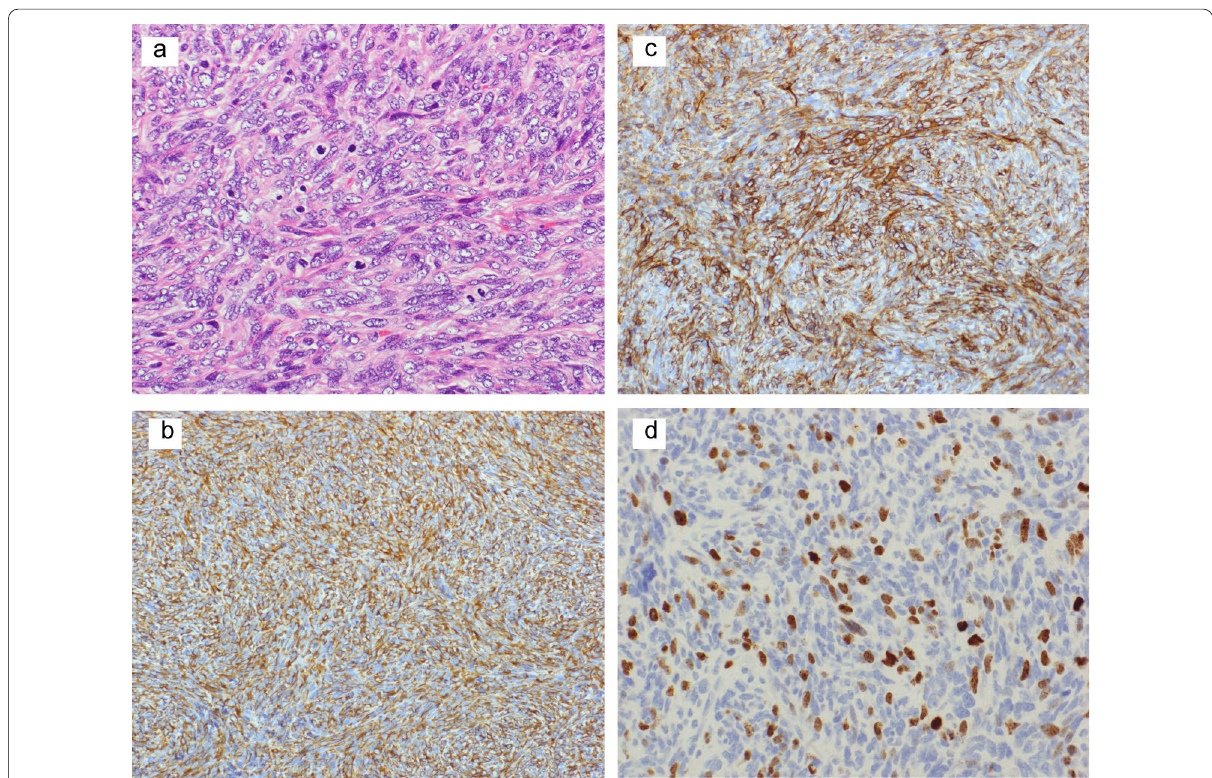
Fig. 4 Histological findings (HE and immunohistochemical staining). a Lung tumors consisted of spindle-shaped cells with a patternless arrangement and hemangiopericytomatous appearance ( 200); b , c immunohistochemical stains were positive for b CD34 and c vimentin; d MIB-1 × index was